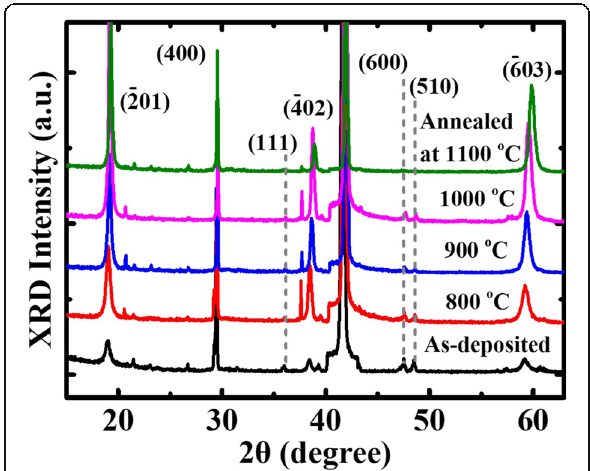
Fig. 2 The XRD peaks of the samples without and with post thermal annealing at different